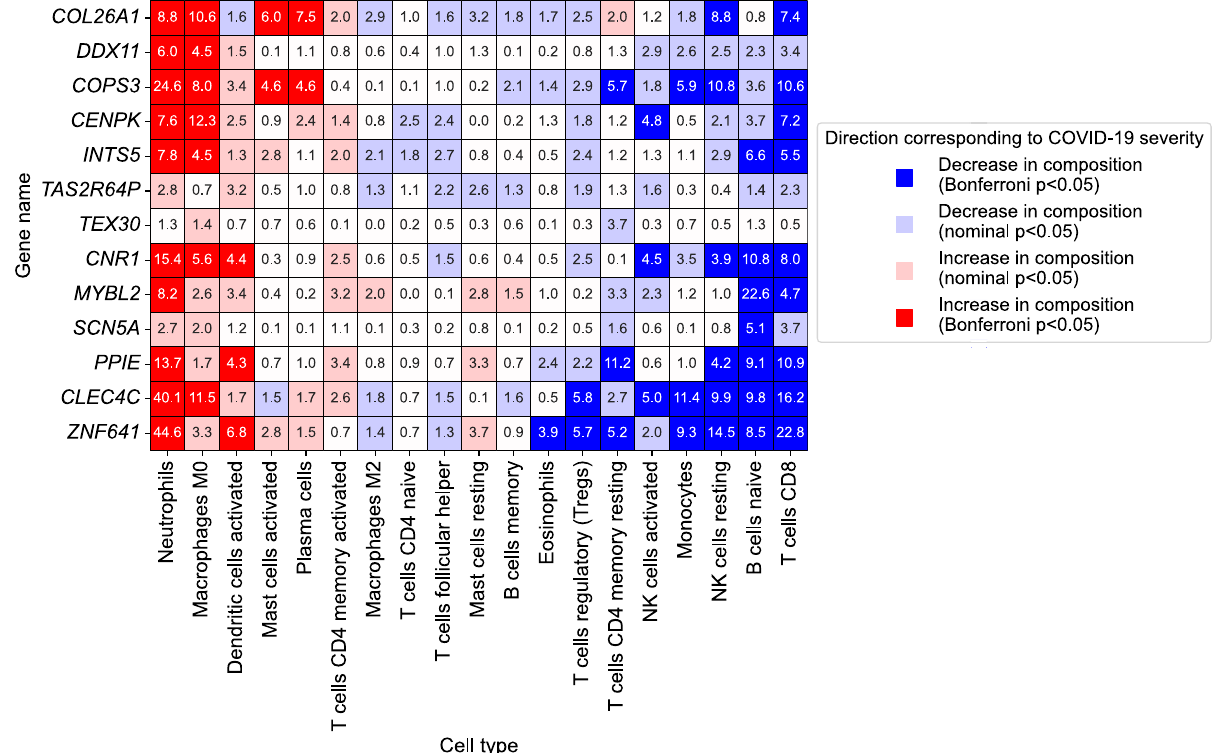
the COVID-19 severity (redmeans severe COVID-19 case corresponds to larger cell type composition in terms of interaction effect, and blue is the other way. Bon- ferroni p =1.7×10 − 4 =0.05/13 genes/22 cell types). Row and columns are sorted based on the number of positive and negative signi fi cant results, where three cell types with no signi fi cant results are